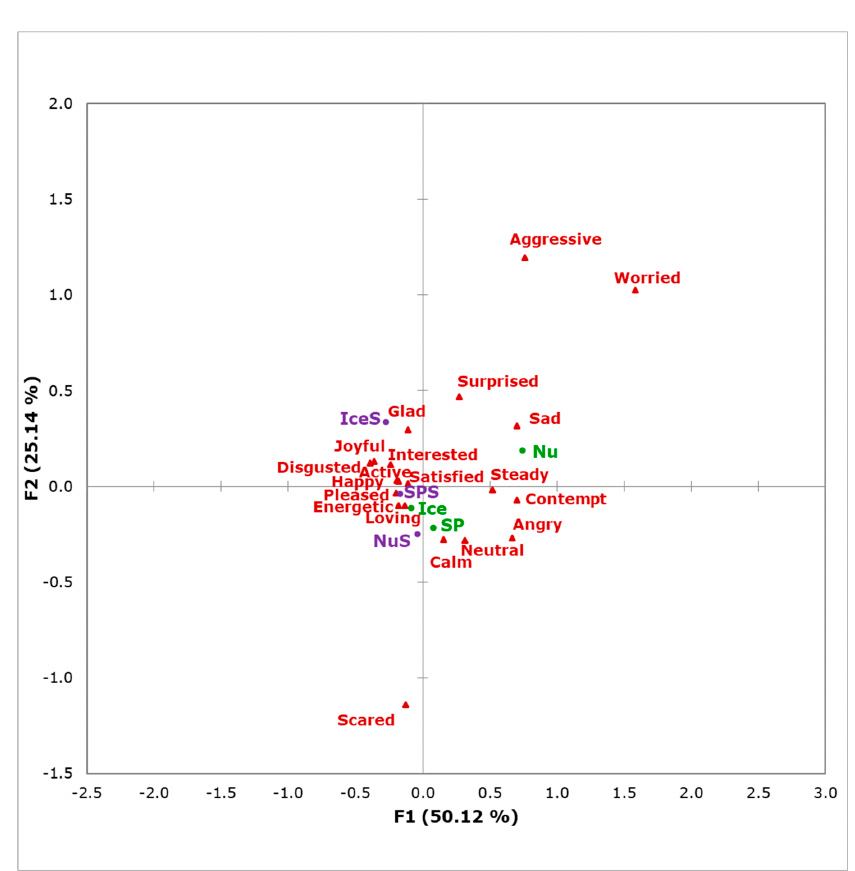
Figure 6. Correspondence analysis of the fizzing sound assessment showing the emotion terms in red and triangles, and the samples in green circles for the control and purple circles for the sonication treatments. Axes represent the contribution of factors 1 and 2 (F1 and F2).